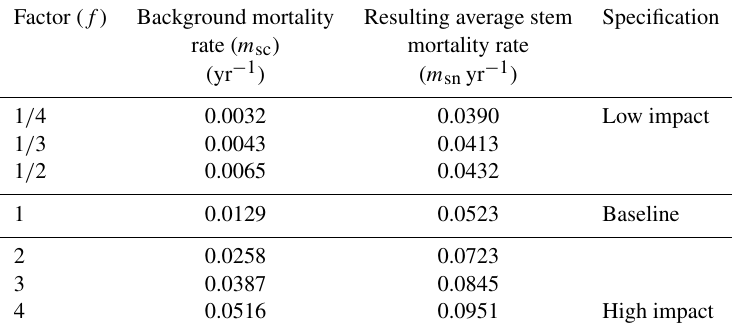
Table 1. Average stem mortality rate per simulation scenario and specification (see Eq. 1). Background mortality rate m sc is the unweighted average over the mortality parameters of eight PFTs in the forest model. The resulting average stem mortality rate is the ratio of dead trees to the total number of trees in a simulated forest stand (averaged over the entire simulation